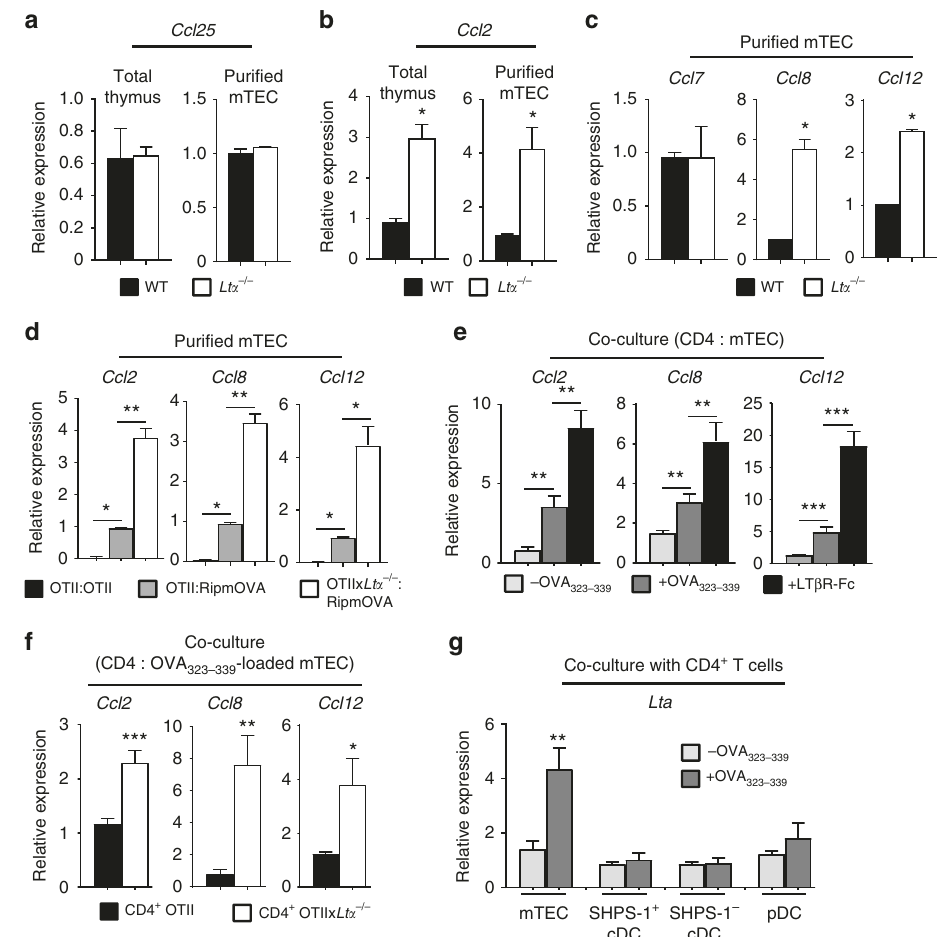
Fig. 3 LT α negatively regulates CCL2, CCL8 and CCL12 expression in mTECs during crosstalk with CD4 + thymocytes. a – b Ccl25 ( a ) and Ccl2 ( b ) mRNAs were measured by qPCR in the total thymus and in puri fi ed mTECs (CD45 - Ep-CAM + BP-1 lo UEA-1 + ) from WT ( n = 5) and Lt α − / − ( n = 5) mice. c Ccl7 , Ccl8 and Ccl12 mRNAs were measured by qPCR in puri fi ed mTECs from WT ( n = 5) and Lt α − / − ( n = 5) mice. d Ccl2 , Ccl8 and Ccl12 mRNAs were measured by qPCR in puri fi ed mTECs from OTII:OTII ( n = 6), OTII:RipmOVA ( n = 6) and OTIIx Lt α − / − :RipmOVA ( n = 6) chimeras. e Ccl2 , Ccl8 and Ccl12 mRNAs were measured by qPCR in puri fi ed mTECs loaded ( n = 6) or not ( n = 6) with OVA 323 – 339 peptide co-cultured with OTII CD4 + thymocytes in the presence or not of recombinant LT β R ‐ Fc chimera. f Ccl2 , Ccl8 and Ccl12 mRNAs were measured by qPCR in puri fi ed mTECs loaded with OVA 323 – 339 peptide and co- cultured with CD4 + thymocytes from OTII- Rag2 − / − ( n = 9) or OTII- Rag2 − / − x Lt α − / − ( n = 9) mice. g Lta mRNA was measured by qPCR in puri fi ed OTII CD4 + thymocytes co-cultured with mTECs ( n = 7), thymic SHPS-1 + cDCs ( n = 8), SHPS-1 - cDCs ( n = 8) and pDCs ( n = 8) loaded or not with OVA 323 – 339 peptide. a – g Data are representative of two independent experiments. Error bars show mean ± SEM, * p < 0.05, ** p < 0.01, *** p < 0.001 using two-tailed Mann – Whitney test for b – d , and unpaired Student ’ s t -test for e –